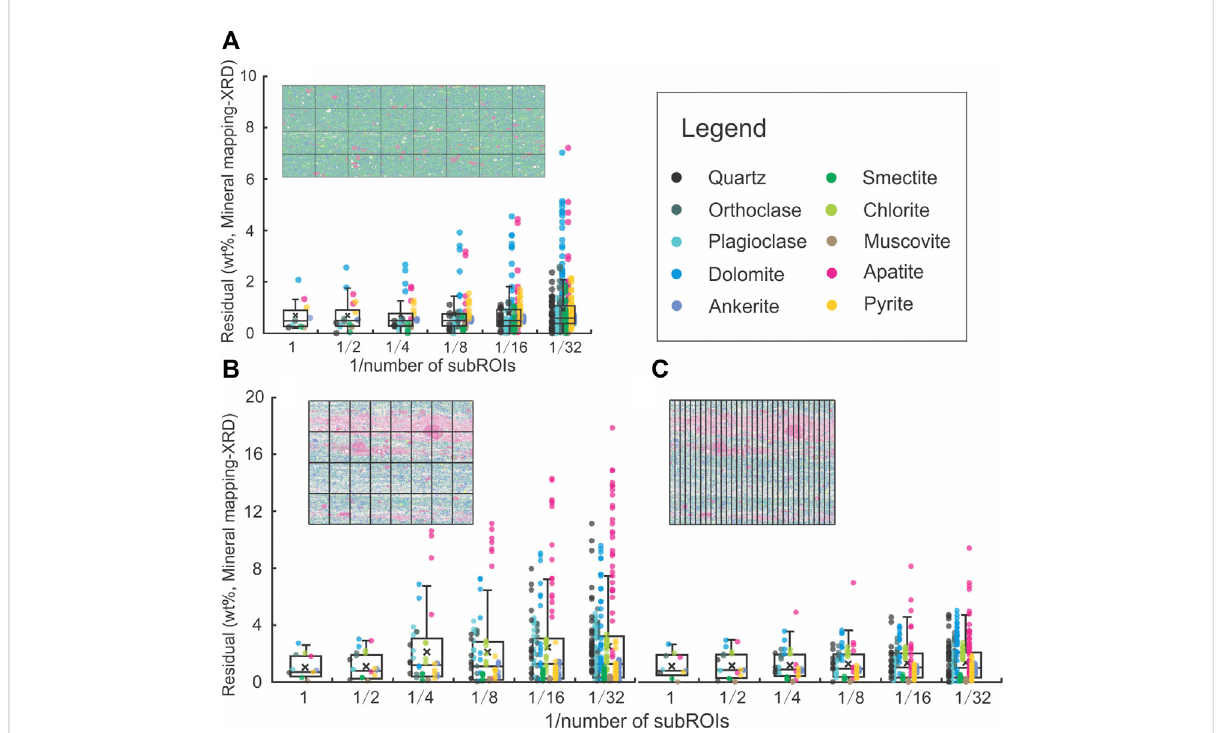
FIGURE 6 Boxplotsofmineralmapping-XRDresidualforahomogeneousandaheterogenoussamplehighlightingtheincreasingdifferenceandreduced reproducibilitybetweenbulksampleXRDcompositionandSEM-EDSmineralcompositionwithdecreasingROIsize.wt%(Residual)=wt%(SEM-EDS mineral mapping) - wt% (XRD). (A) Box plot of mineral mapping-XRD residual for homogeneous sample SX22_1 and mineral map overview image at 50%transparency. (B,C) BoxplotofSEM-EDSmineralmapping-XRD residualfor laminated sampleQlk6 ROI1andmineral mapoverview image at 50% transparency with gridded ROIs (B) and columnar ROIs perpendicular to bedding (C) . ROIs organized as vertical columns (C) provided results more consistent with bulk mineralogy for samples with signi fi cant compositional heterogeneity (e.g., mineralogically distinct